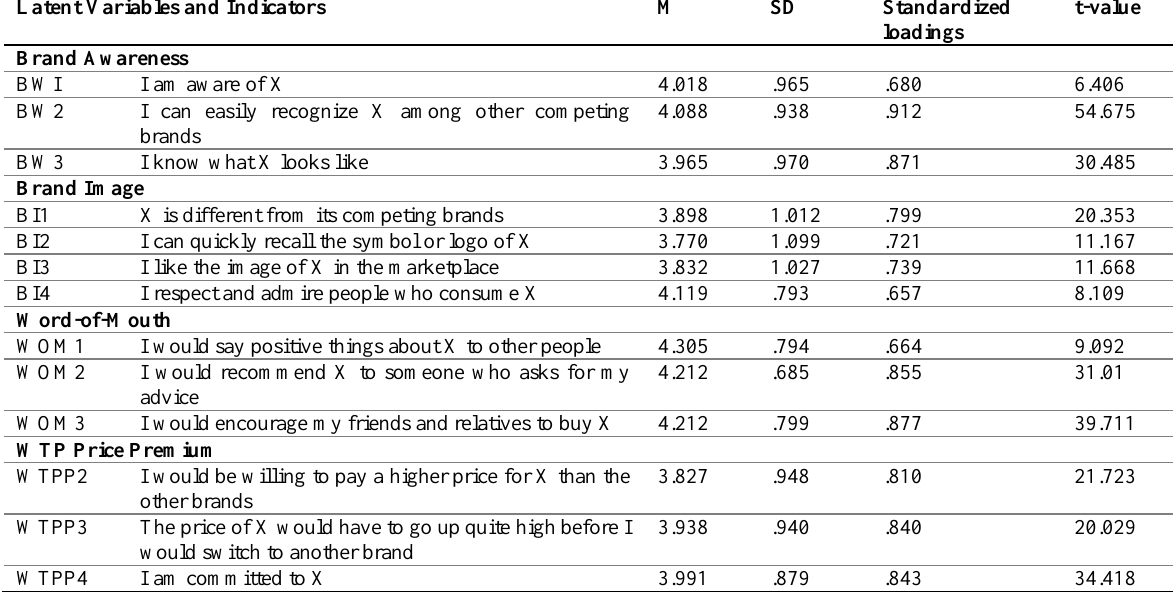
Table 2: Results of Measurement Model